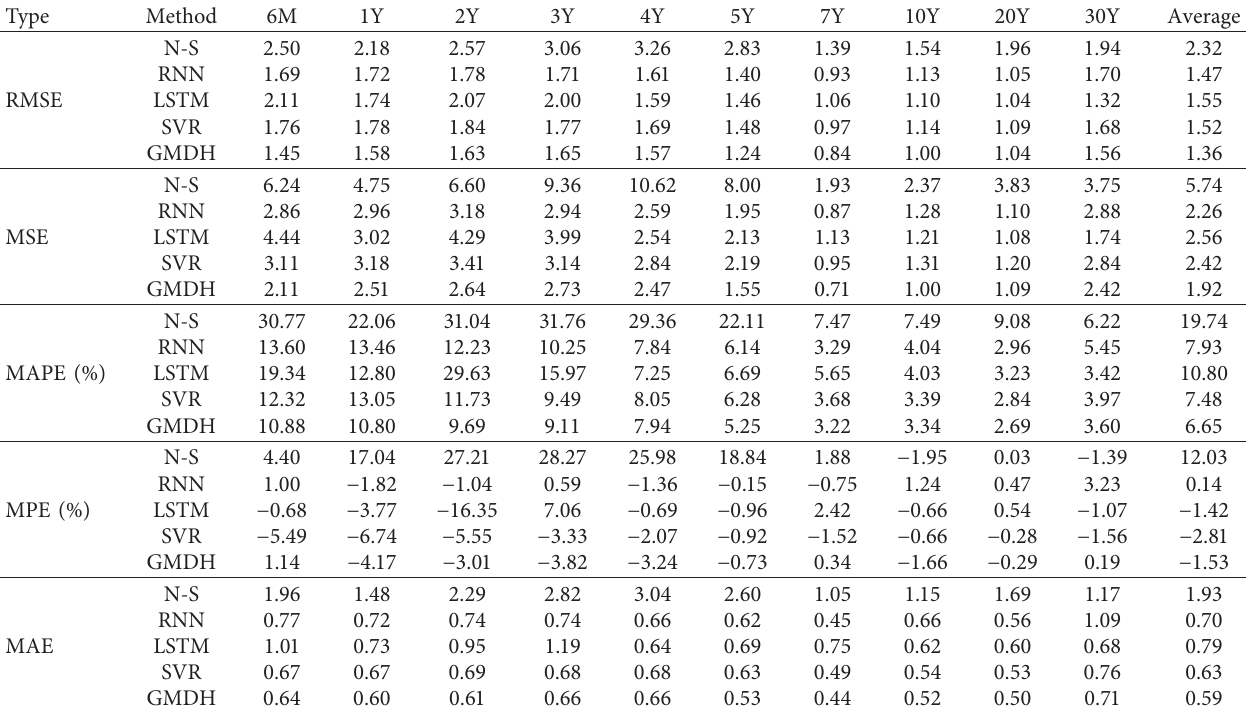
Table 8: Error statistics of each method for all maturities for test dataset 1 with the subperiod 2 training set (case 3). Type